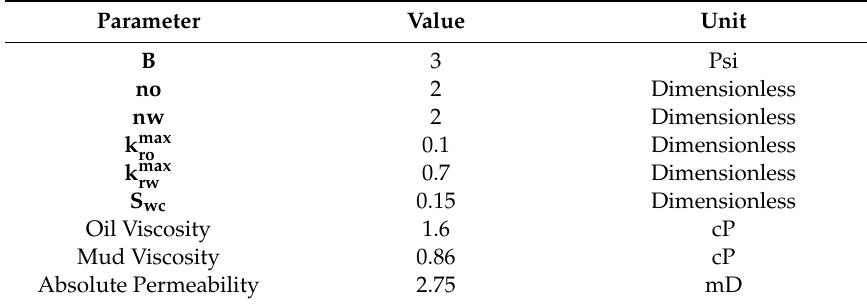
Table 1. Required parameters for modelling according to the provided core samples for CT scan